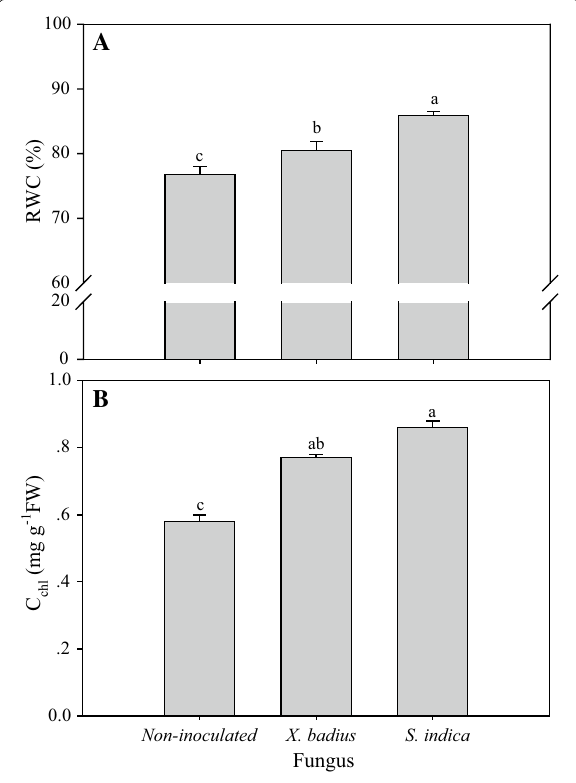
Fig. 6 Effect of X. badius and S. indica inoculation on RWC ( A ) and C chl ( B ) in leaves of L. multiflorum seedlings. C chl : content of leaf chlorophyll, RWC: leaf relative water content. Values are means of six replicates. Bars represent the standard deviation. Lowercases show statistically significant differences for the same parameter among